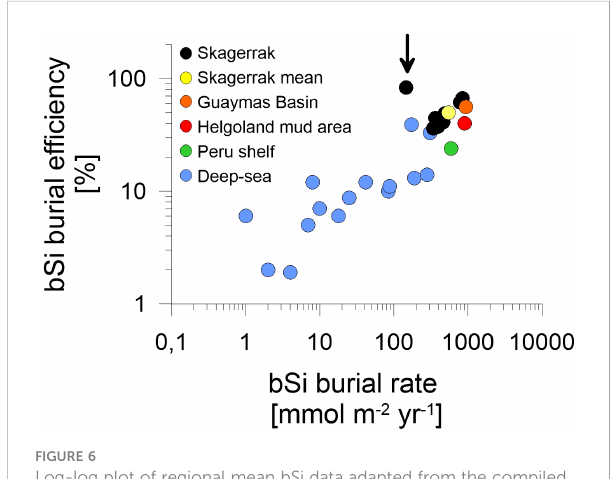
FIGURE 6 Log-log plot of regional mean bSi data adapted from the compiled dataset presented by Dale et al. (2021). Biogenic silica burial rates are plotted against bSi burial ef fi ciencies. Individual Skagerrak stations (black) and a Skagerrak mean value of stations > 400 m water depth (yellow) are compared to deep-sea regions at >3000 m water depth (blue), the Peru shelf (green) by Froelich et al. (1988), the Helgoland mud area (red) by Oehler et al. (2015b) and the Guaymas Basin (orange) by Geilert et al. (2020). Data indicated by the arrow corresponds to sandy station